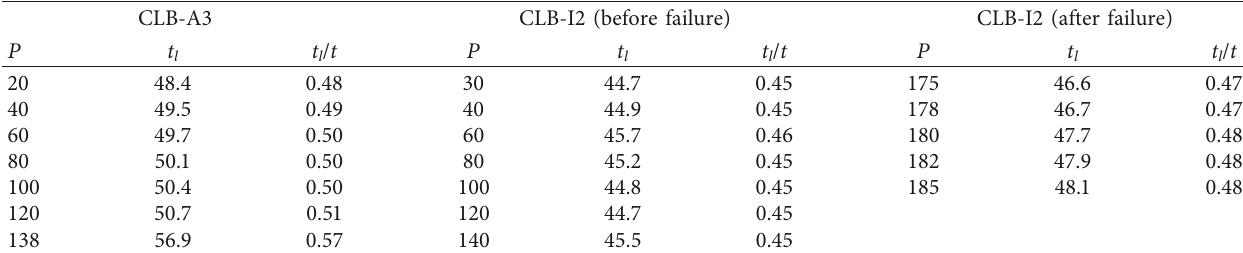
Table 6: Positions of neutral axis under different